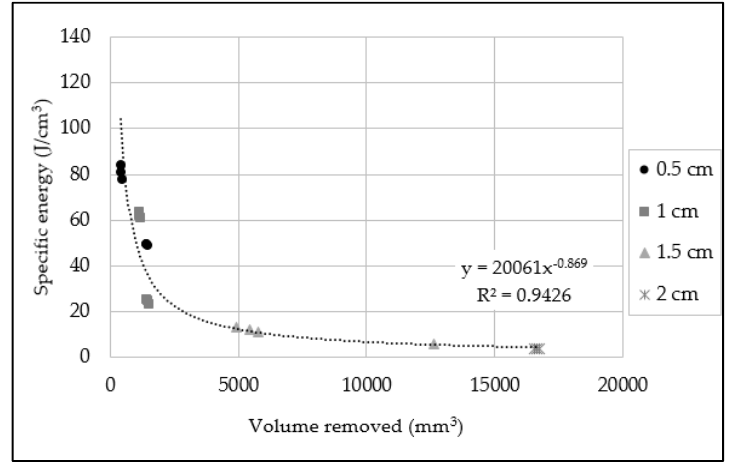
Figure 9. Specific energy as a function of volume removed in samples with c/s ratio 1:1.